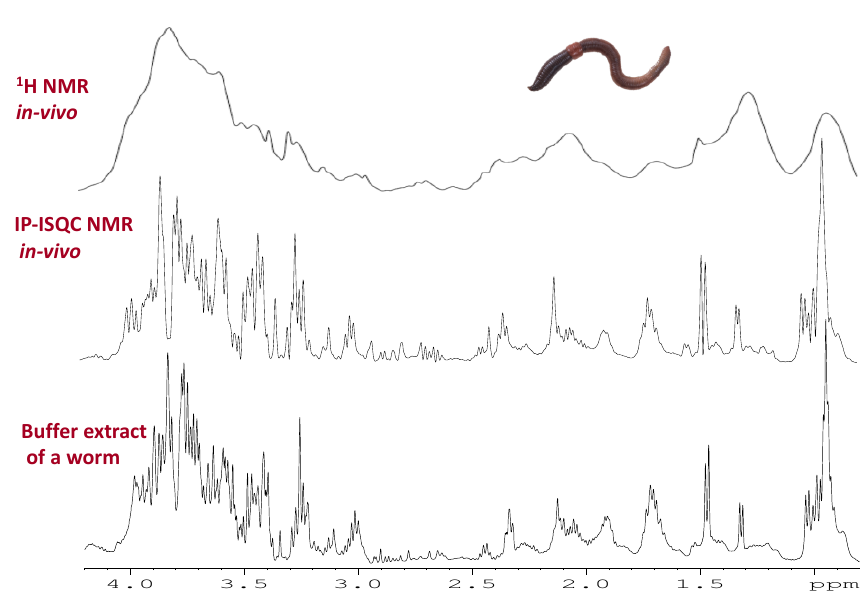
Figure 6. Example of an IP-iSQC NMR spectrum [153] which is used to remove magnetic susceptibility distortions from in-vivo NMR. The top spectrum shows a conventional 1 H in-vivo NMR spectrum of a worm. 1 H IP-iSQC approach which uses a 2D sequence to remove the distortions for the same worm (in-vivo). The bottom is a buffer extract from a similar worm (ex-vivo). The results demonstrate that the in-vivo IP-iSQC experiment produced near identical line shape, integral, and spectral profile as a buffer extract. Modified with permission from John Wiley and Sons.